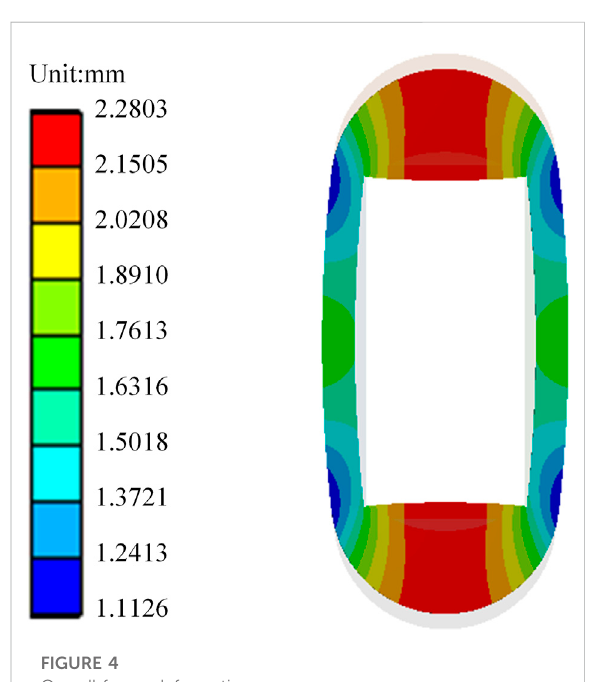
FIGURE 5 Vertical deformation of HPC y -direction